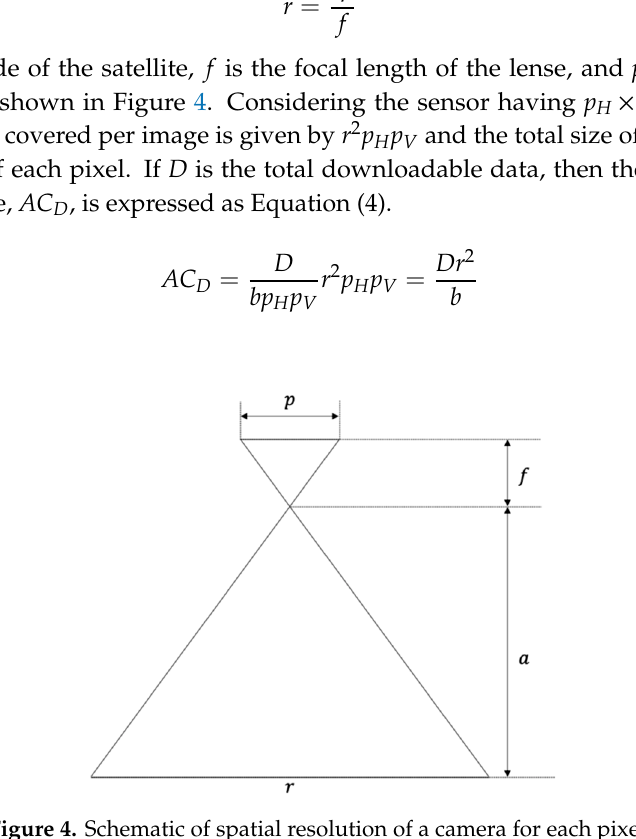
Figure 4. Schematic of spatial resolution of a camera for each pixel.